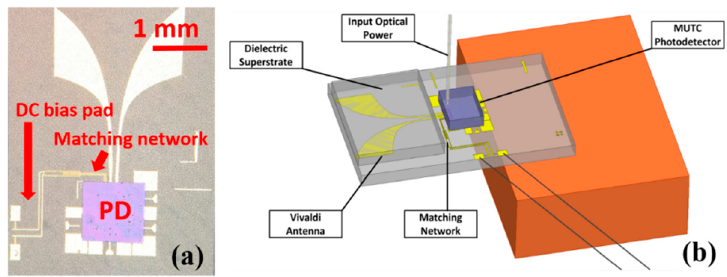
Figure 7. ( a ) Optical image and ( b ) 3-D schematic of the integrated photonic emitter.